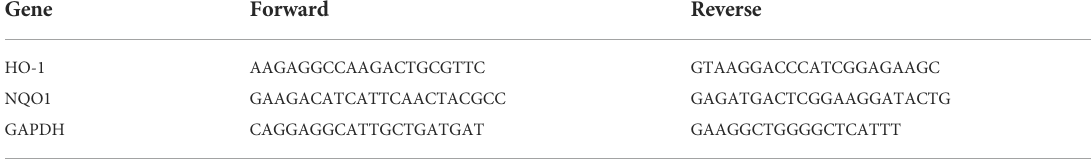
TABLE 2 The PCR primers sequences for RT-qPCR(Human). Gene